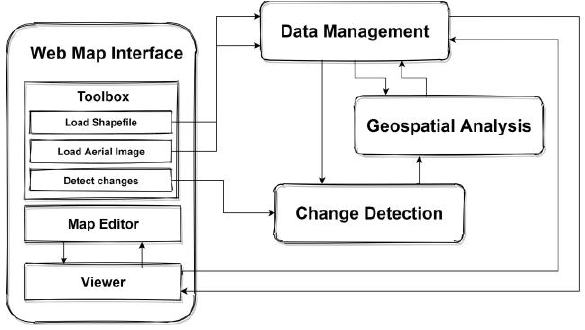
Figure 1. The system workflow.